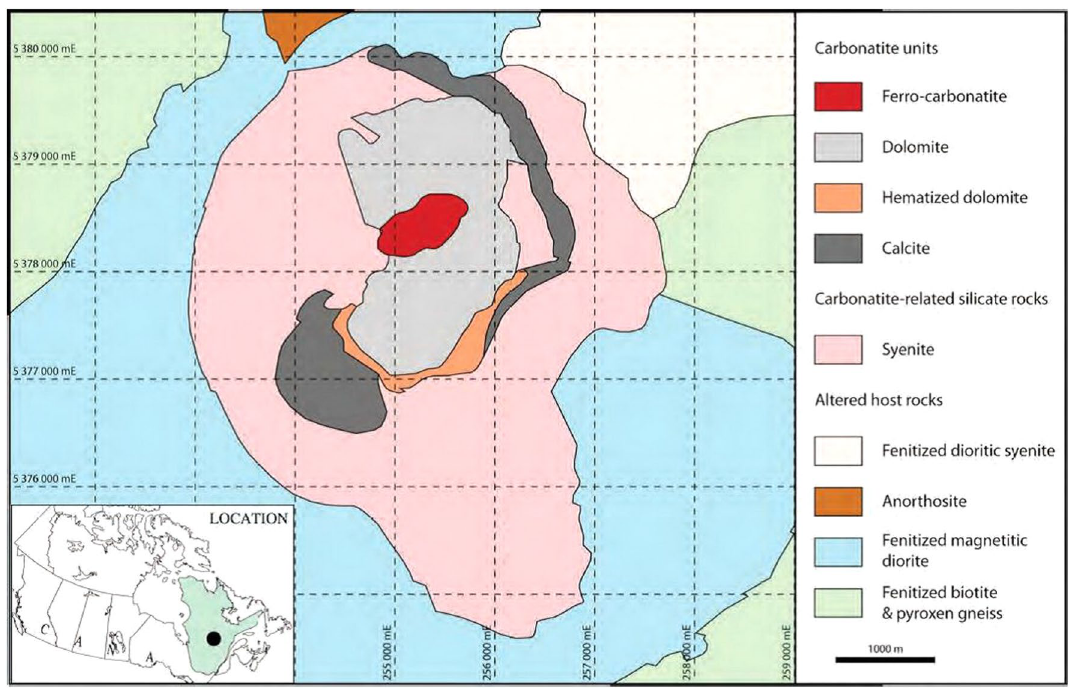
Fig. 1 Geological map of the Saint-Honoré alkaline complex (after Tremblay et al.